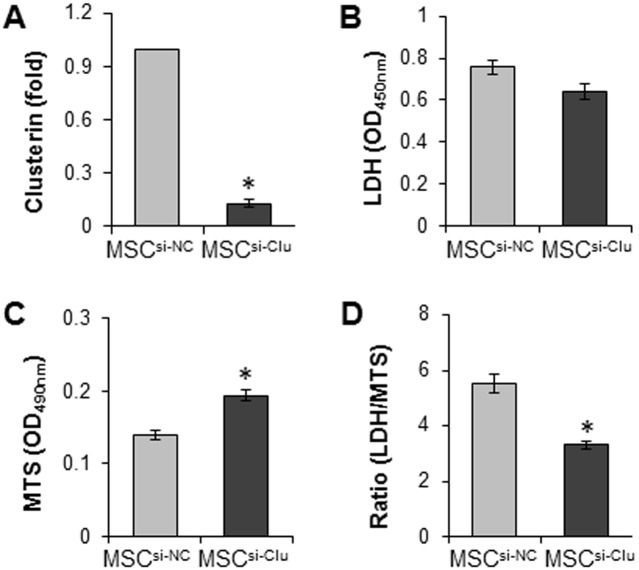
MSCGATA-4 transfected with Clu-siRNA (MSCsiRNA-Clu) and transfected with negative control siRNA (MSCsiRNA-NC) were exposed to hypoxia for 72 h.A. The expression of clusterin in MSCsiRNA-Clu and MSCsiRNA-NC; B. LDH release; C. MTs intake; D. Ratio of LDH to MTs. *, p < 0.05 vs MSCsiRNA-NC. MSCsi-Clu = MSCsiRNA-Clu; MSCsi-NC = MSCsiRNA-NC.